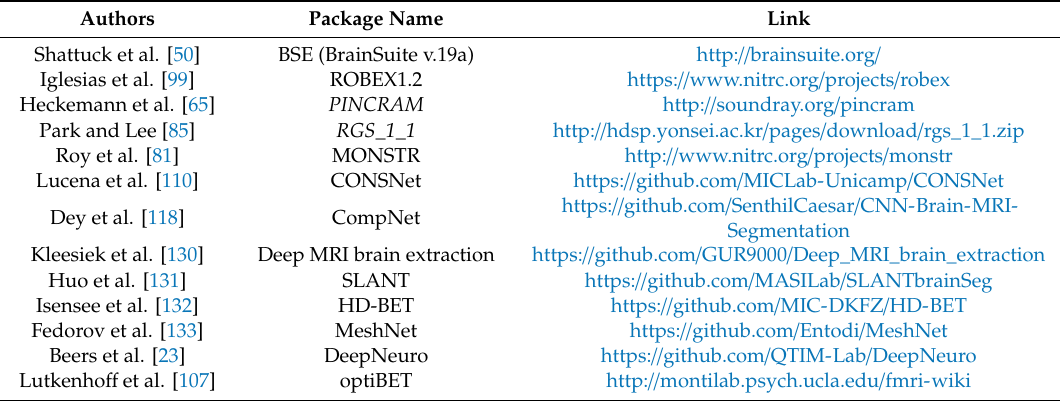
Table 5. Publicly available conventical and deep learning